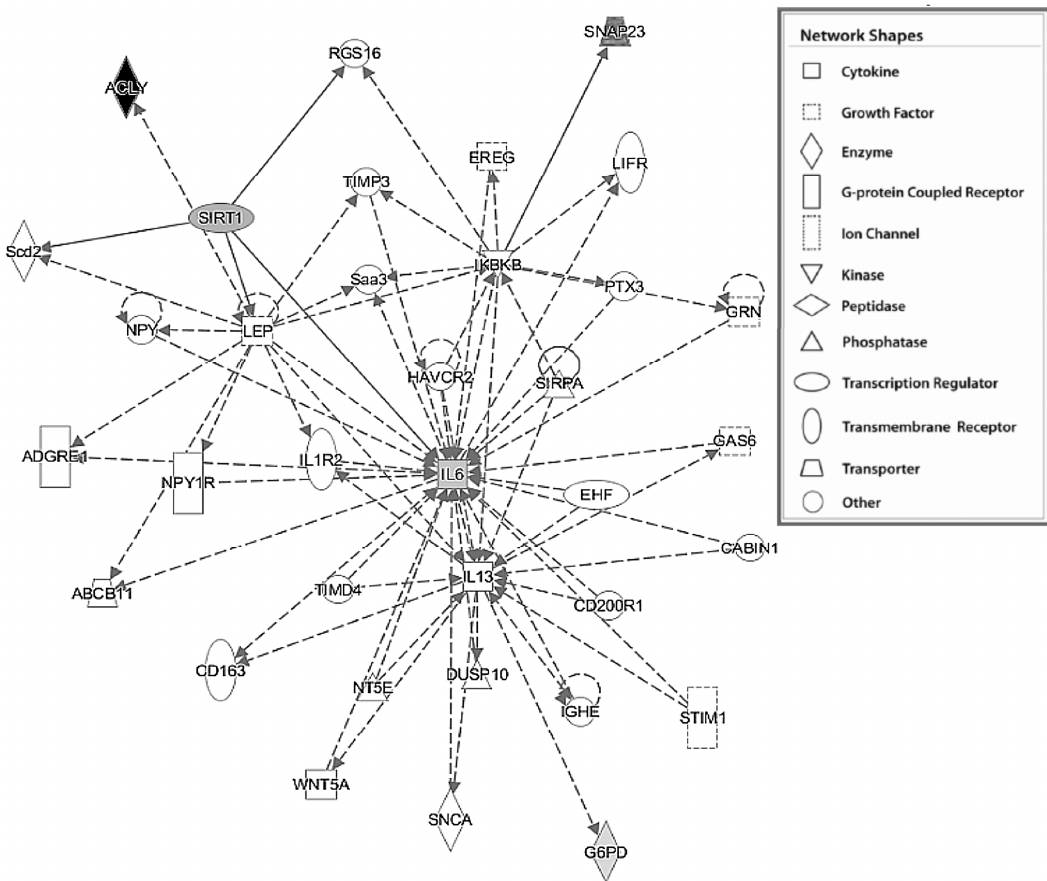
Figure 3. Cell-to cell signaling and interaction, hematological system development and function, inflammatory response network in the GDM/ SIRT1 ( ↑ ) patients, as identified by IPA. The five genes ( SIRT1 , ACLY , G6PD , IL6 , and SNAP23 ) verified as significant in the entire GDM/ SIRT1 ( ↑ ) group ( p < 0.05) were converted into a gene network by IPA software. The figure displays the network graphically as nodes (gene/gene product) and edges (biological relationship between nodes). The up-regulated genes are shown in gray shading, with the color intensity indicating the fold change in expression, whereas the down-regulated gene ( ACLY ) is shown in black. A direct relationship is presented as a straight line, and an indirect relationship as a dotted line. Genes involved in the network that are not included in the transcriptome results are shown in white. The node shapes are indicative of function, with the legend given to the right.